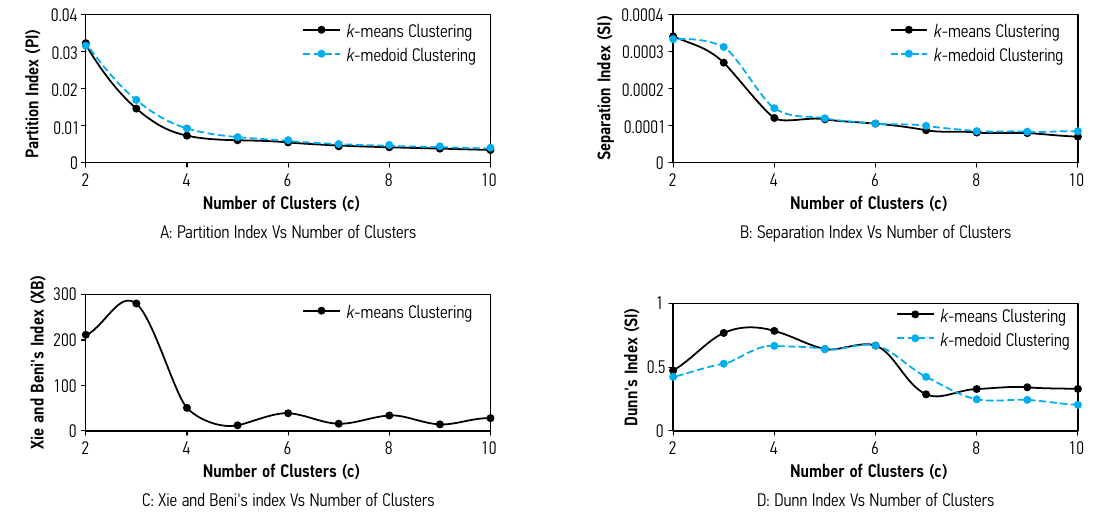
Fig. 2. Validation measures for optimal number of clusters